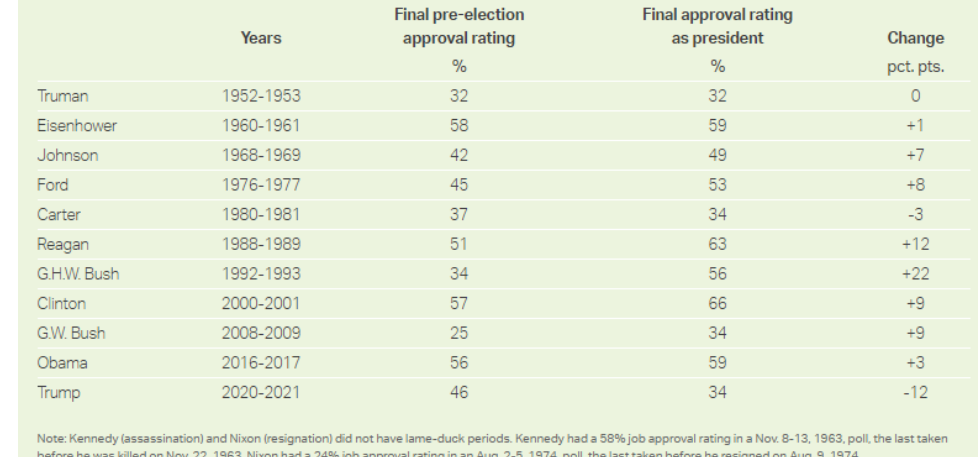
Figure 2. Changes in Presidential Job Approval During the Lame-Duck Period. Source: (Gallup Poll 2021).